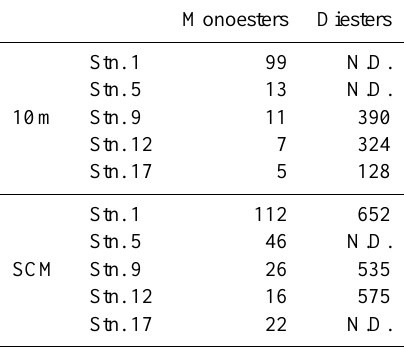
Table 3. Turnover times (days) of phosphate monoesters and di- esters calculated from kinetic parameters. N.D. means a value was not obtained because of unsuccessful fitting. For details on calcula- tions, see the Materials and methods and the Results